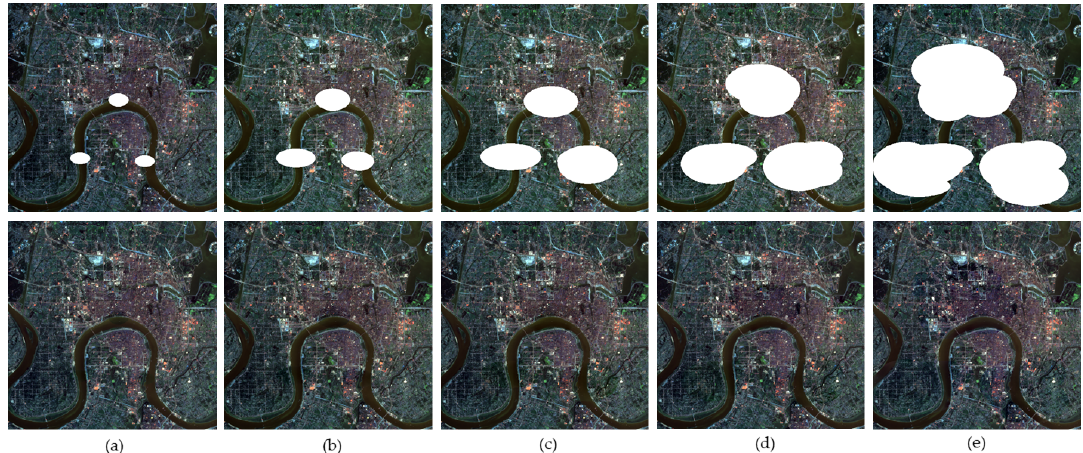
Figure 13. The simulated images and results with different cloud sizes. The proportions of cloud pixels in the simulated images are 1.34% ( a ), 3.92% ( b ), 10.35% ( c ), 19.74% ( d ), 34.84% ( e ), respectively.